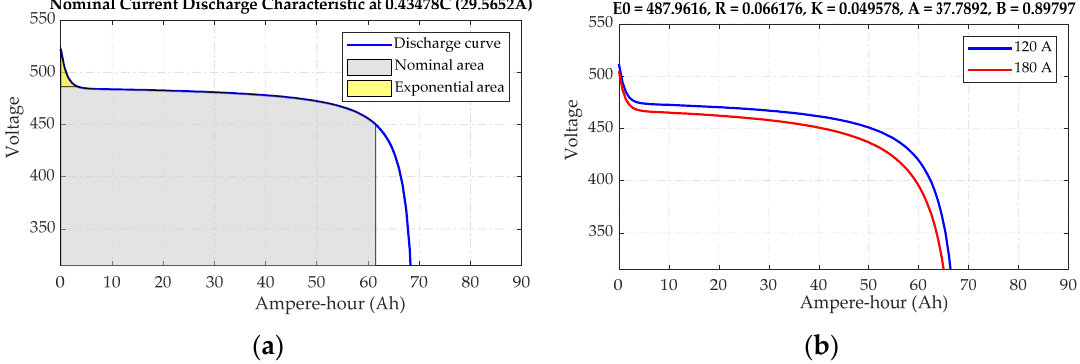
Figure 3. Polarization curves of BAT. ( a ) Nominal current discharge characteristic; ( b ) Discharge current.